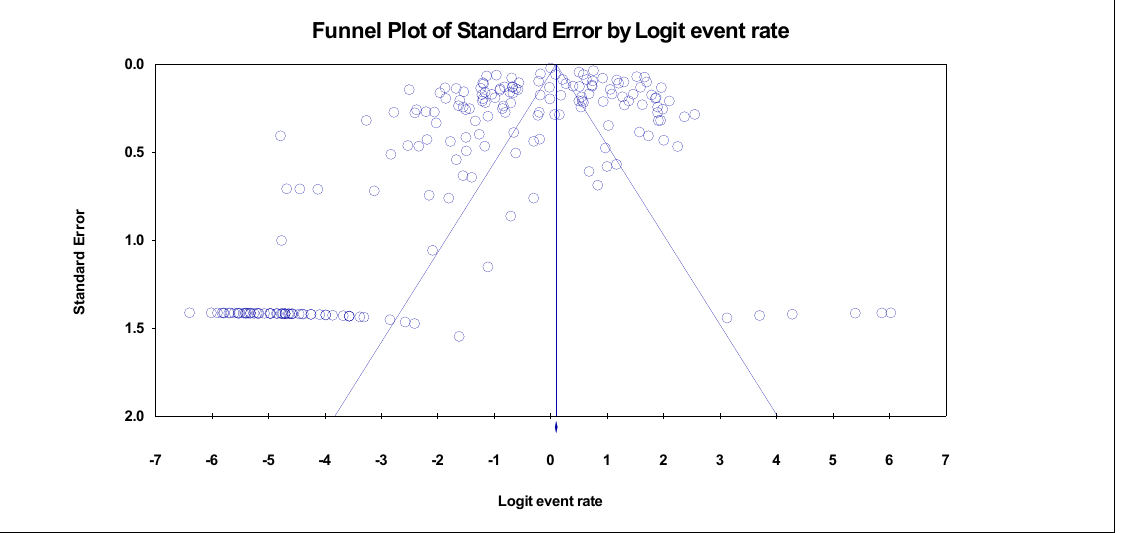
Figure 2. A funnel plot showing no publication bias for HBV genotype C in Asia (Egger’s p = 0.00001).